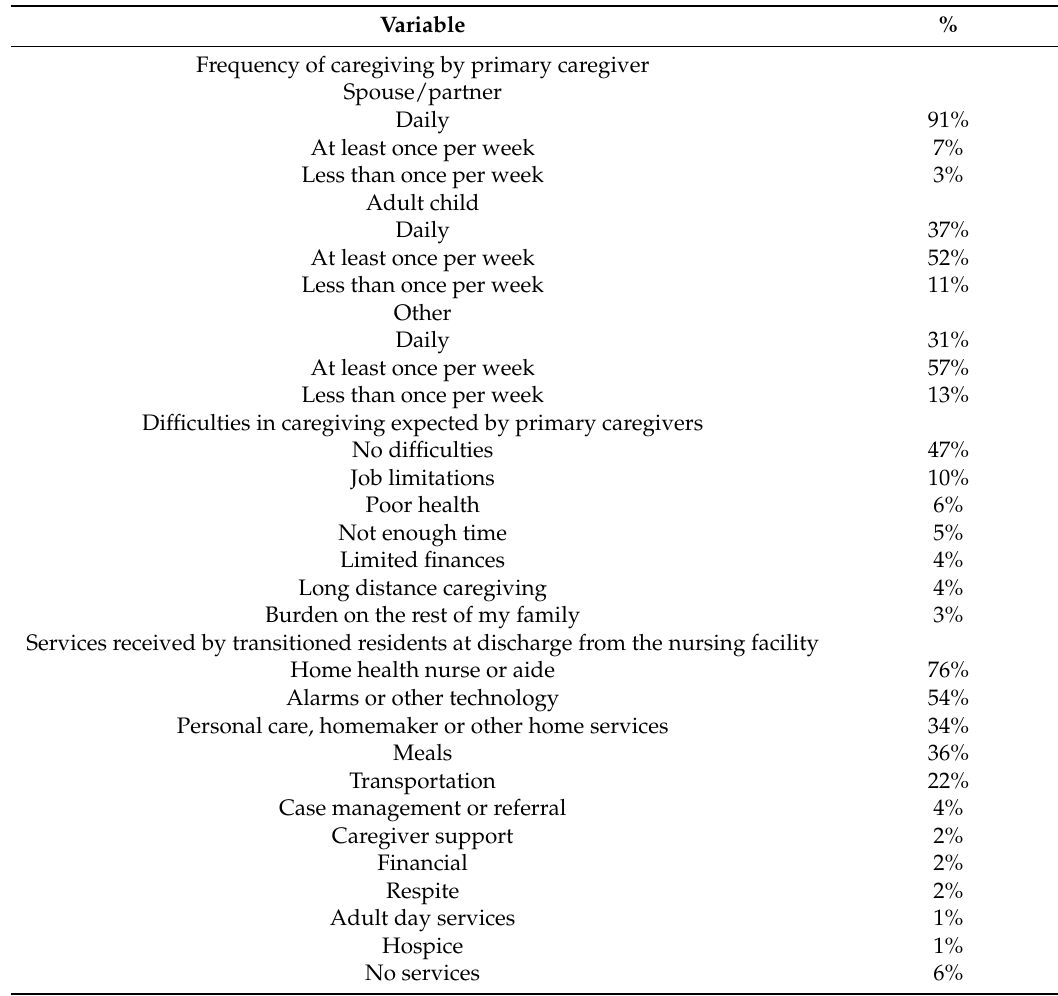
Table 3. Informal care and formal services at transition from the nursing facility. (N = 1216 transitioned residents and N = 920 primary